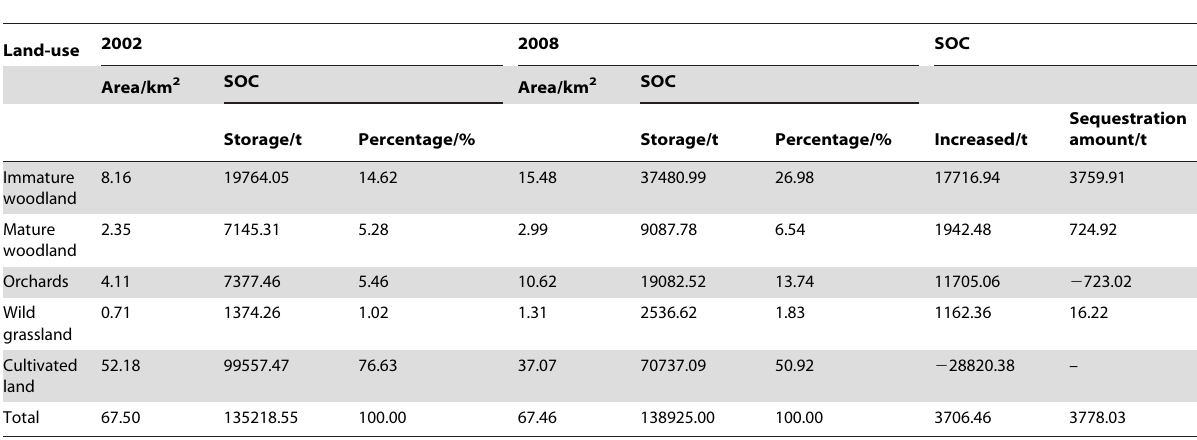
Table 3. Change in SOC storage from 2002 to 2008 in the Luoyugou